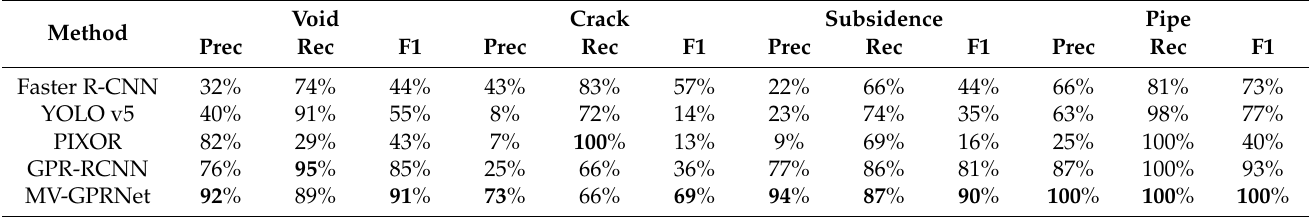
Table 2. Defect detection results on AUD dataset.